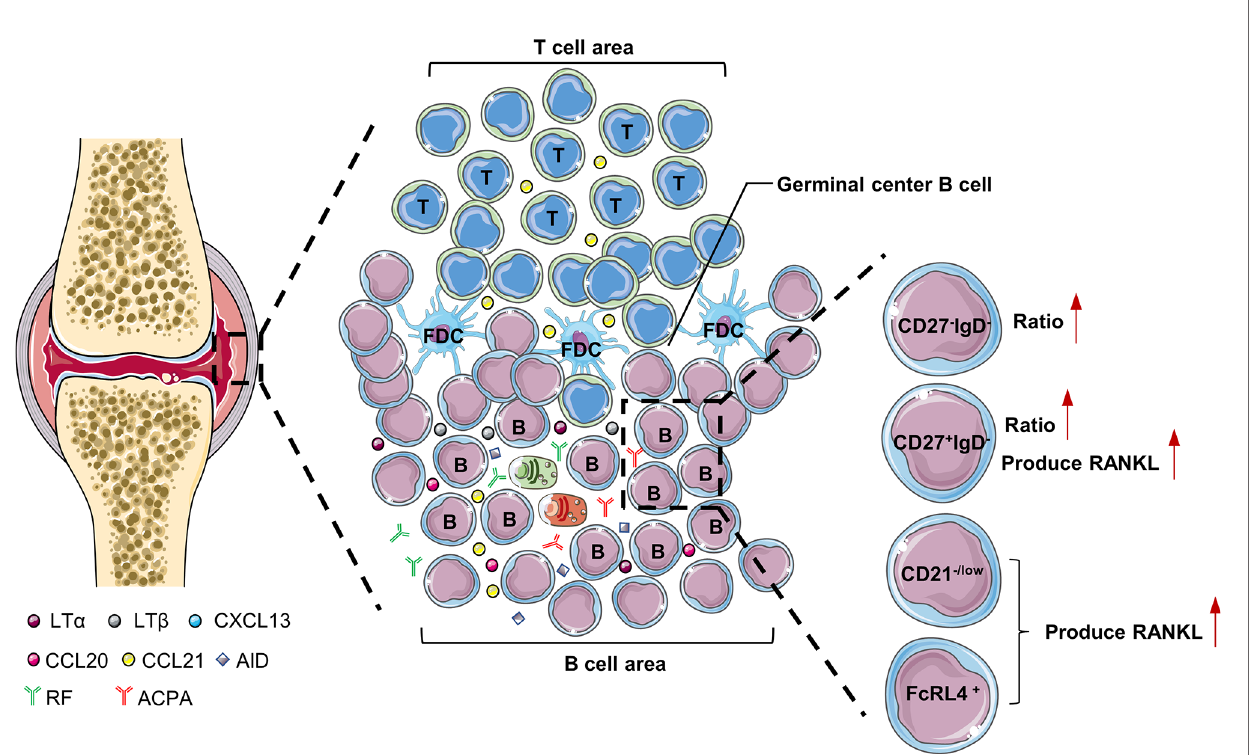
FIGURE 1 | B cells in the synovium of RA. LT a and LT b secreted by B cells are very important for maintaining the aggregated T cell and B cell in fi ltrate in the synovial tissue of RA patients. FcRL4 + B cells, CD27 + IgD - B cells and CD21 -/low B cells are prone to produce RANKL, which are pathogenic B cells in the synovium of RA patients. LT a , lymphotoxin a ; LT b , lymphotoxin b ; AID, Activation-induced cytidine deaminase; CXCL, C-X-C motif chemokine ligand; FcRL4, Fc receptor-like